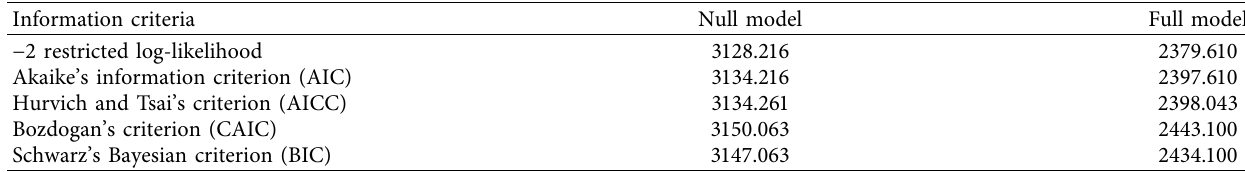
Table 9: The information criteria output from stabilization time model by LOS and curvature.